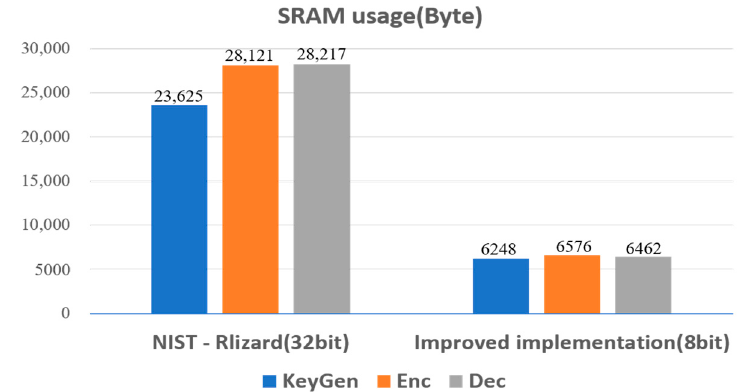
Figure 5. Comparison on SRAM usage: [7] and the proposed implementation.